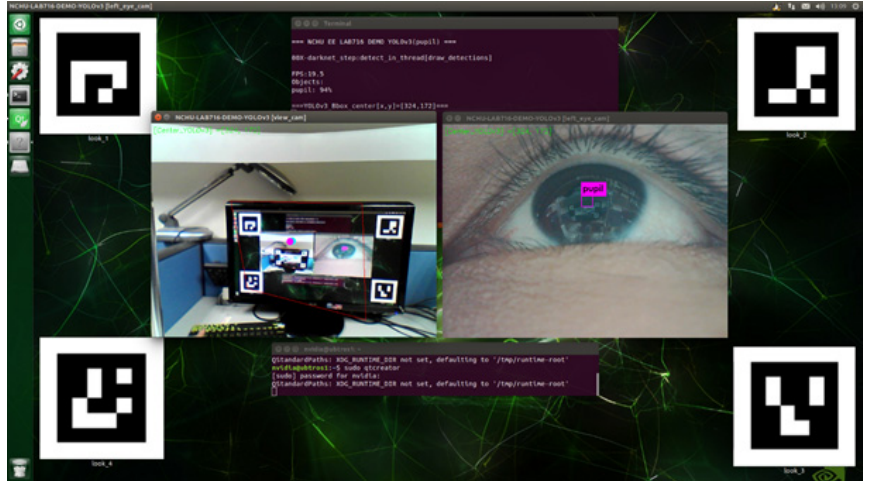
Figure 17. Implementation of the proposed gaze tracking design on Nvidia Xavier embedded platform.